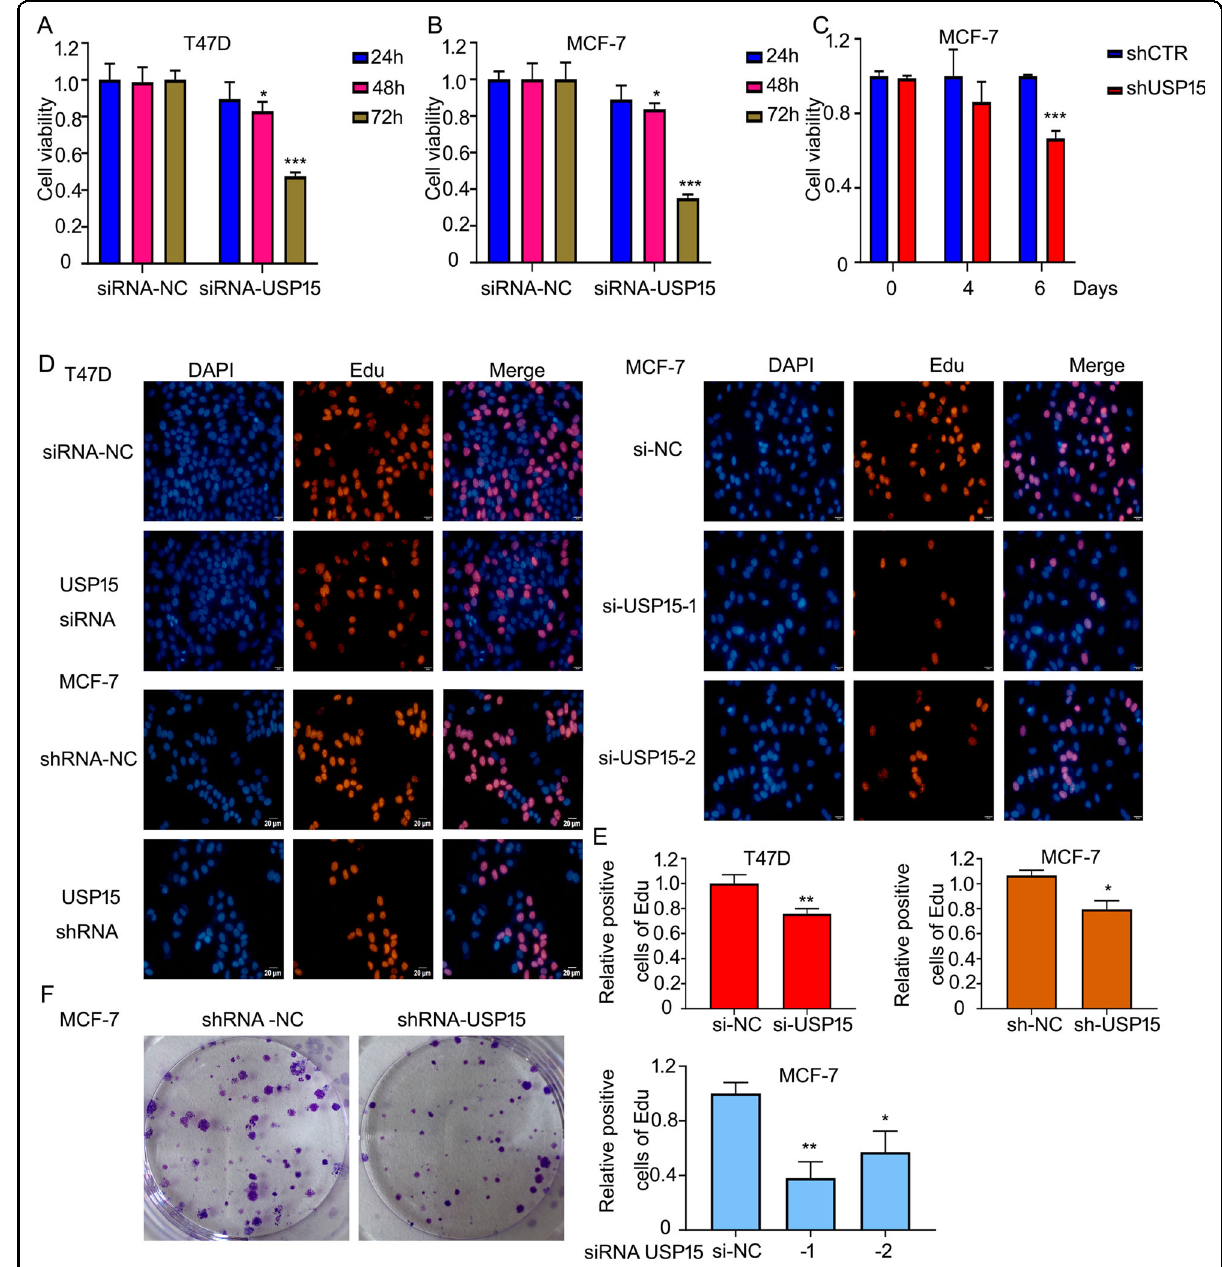
C MCF-7 cells stably expressing USP15 shRNA were cultured in 96-wells plates for 4 and 6 days. 20 μ l MTS was applied to react for this test of cell viability. * p < 0.05, ** p < 0.01, *** p < 0.001 versus each vehicle control. D Cells were transfected with USP15 siRNA or MCF-7 cells were transfected with different sets of USP15 siRNA for 48 h. Edu agent was added and subjected to fl uorescence microscope. E Stained cells by Edu were counted. * p < 0.05, ** p < 0.01 versus each vehicle control. f Colony formation assay was carried out in MCF-7 treated with USP15 shRNA for 10-14